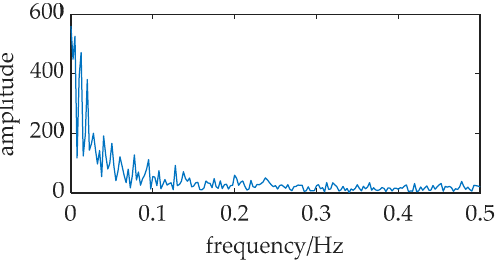
Figure 7. The frequency spectrum of the SR output when the ratio k is small. The relative parameters: A = 0.1, f = 0.2, a = 1, b = 1, D = 0.31, f s = 5.